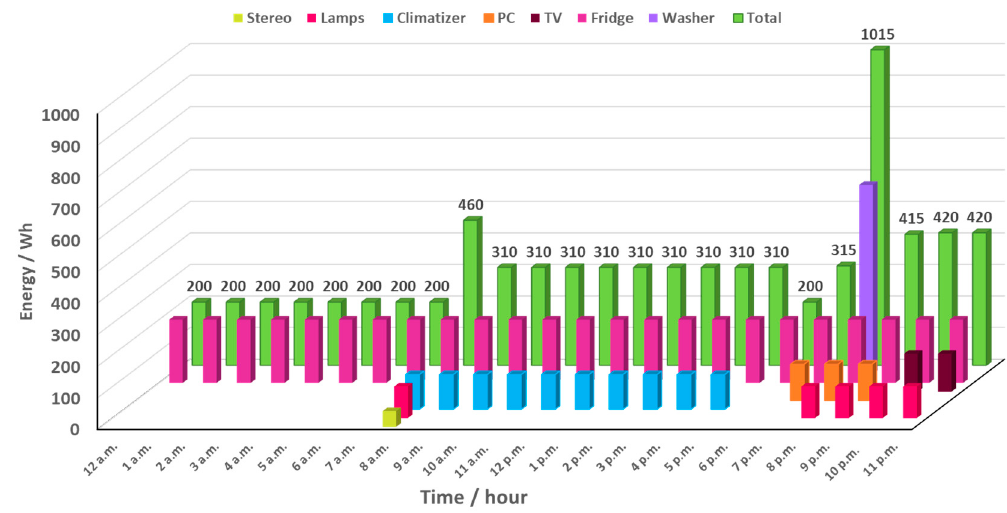
Figure 1. Electrical demand of a one-family house.